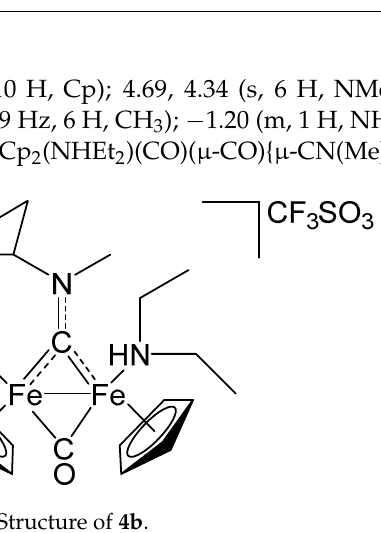
Figure 1. Structure of 2a (left: cis isomer; right: trans isomer).